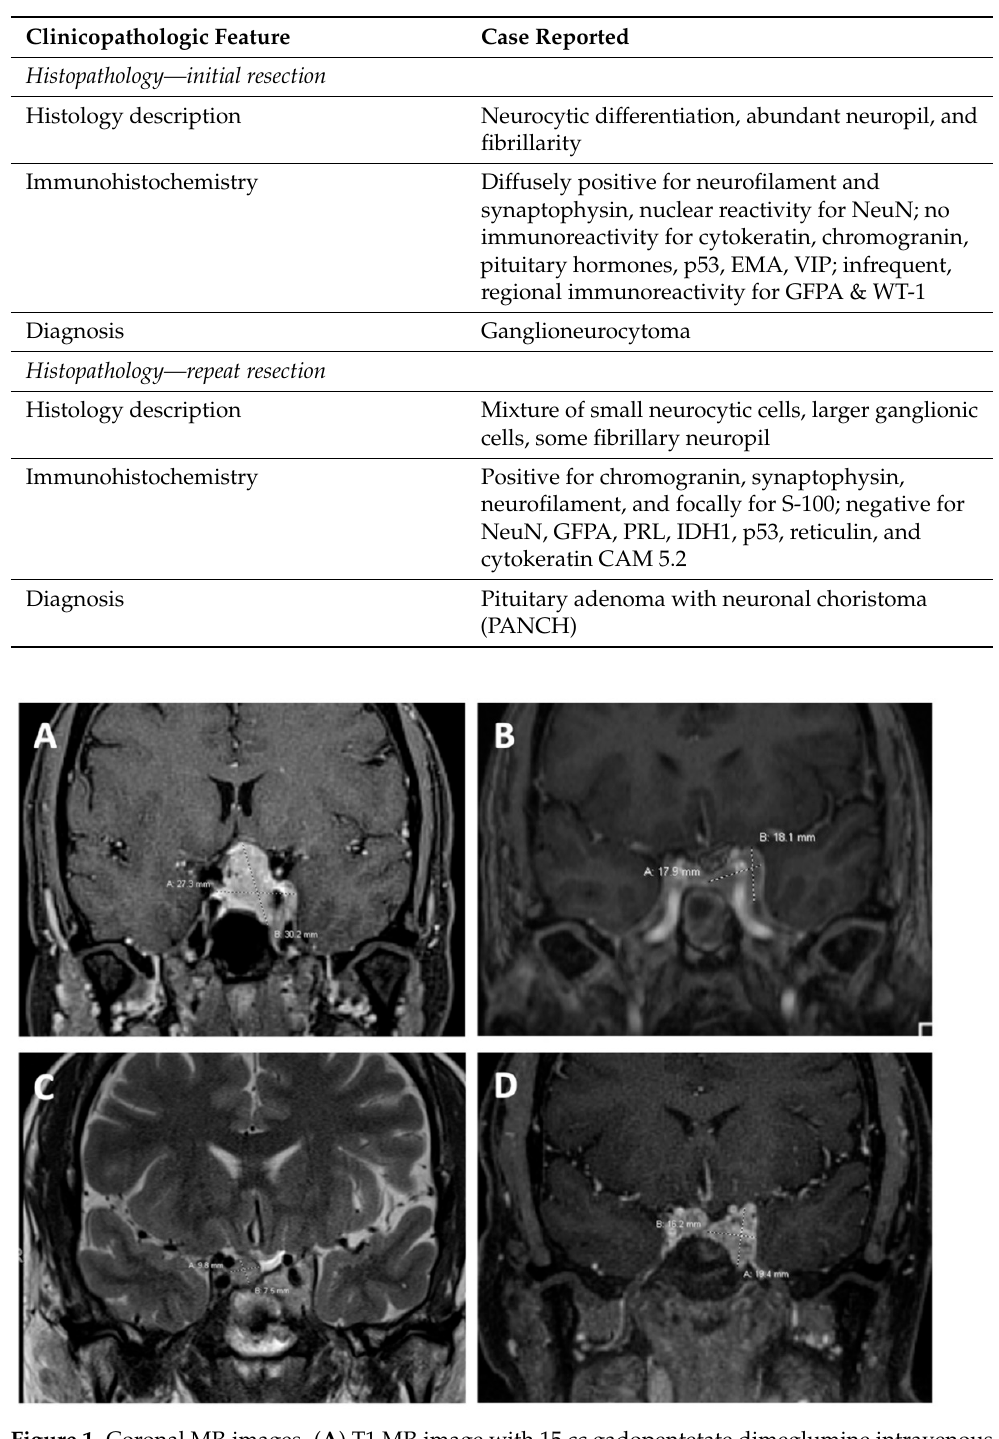
Figure 1. Coronal MR images. ( A ) T1 MR image with 15 cc gadopentetate dimeglumine intravenous contrast taken two years following initial resection showing an enhancing sellar and suprasellar mass (2.2 cm × 2.0 cm × 1.8 cm) that increased in size as per prior report from an outside institution. ( B ) T1 MR image with 4 mL gadobutrol intravenous contrast post repeat transsphenoidal resection of the recurrent mass. There is a stable appearance of the residual lesion (1.6 cm × 1.9 cm). The tumor remained stable until the patients most recent MRI ( C , D ). ( C ) T2 weighted MR image and ( D ) T1 MR image with 4.5 mL gadobutrol contrast showing progression of residual tumor with new right sellar and suprasellar mass (1.0 cm × 0.8 cm).